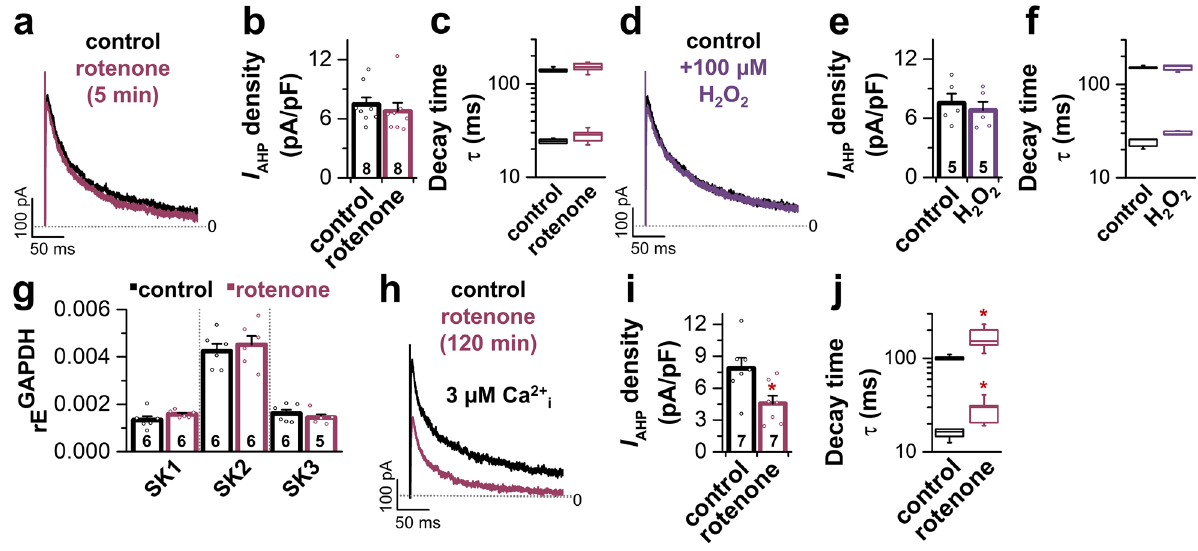
Figure 4. Rotenone-induced I AHP alterations are independent of a direct rotenone effect, oxidative modulation, altered transcription and Ca 2+ sensitivity. ( a ) Representative I AHP recording of a LC neuron before (black) and 5 min after 1 µM rotenone was washed in (red). ( b , c ) Acute rotenone exposure did not alter I AHP current density (n = 8) ( b ) or decay time (n = 6) ( c ). ( d ) Representative I AHP recording of a LC neuron before (black) and 5 min after 100 µM H 2 O 2 was washed in (purple). ( e , f ) Wash-in of 100 µM H 2 O 2 did not alter I AHP peak current density ( e ) or current kinetic ( f ) within 5 min of wash-in (n = 5). ( g ) Relative expression (rE) levels of SK1, SK2 and SK3 channel subunits normalized to GAPDH. For expression analysis, LC neurons were collected out of acute brainstem slices (2 h incubation in ACSF (control) or 2 h incubation in 1 µM rotenone). ( h ) Representative AHP currents in LC neurons of control slices and slices after 2 h pre-incubation with 1 µM rotenone using high concentrations (3 µM) of free Ca 2+ in the pipette solution to achieve a full SK channel activation. ( i , j ) Use of high [Ca 2+ ] i did not restore the rotenone-induced reduction of I AHP current density (n = 7) ( i ) or current kinetic (n = 5) ( j ). Box plots display median and 25/75 percentile, whiskers indicate outliers. Rest of the data are represented as mean ± SEM and also as individual data points. * p < 0.05. [( b , c ) Mann–Whitney-U test vs. control. ( e , f , g , i ): unpaired Student’s t -test vs. control. ( j ): Welch’s t -test vs.